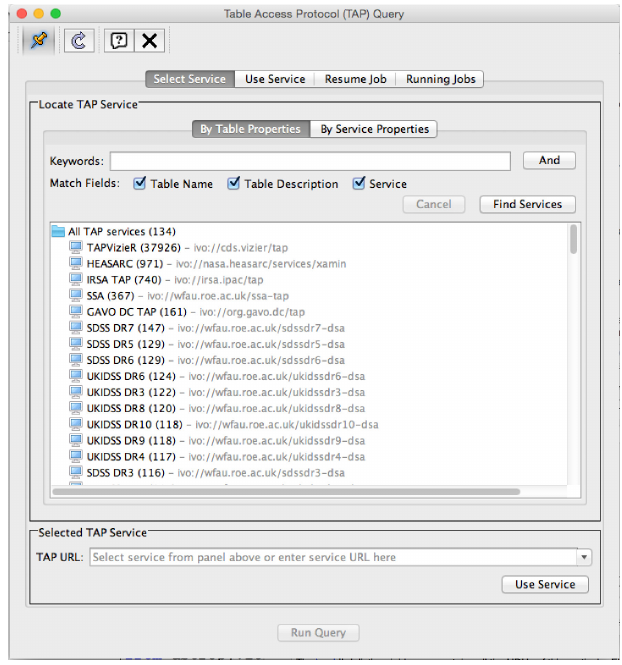
Fig. 55.— The Table Access Protocol (TAP) window from the list in the window, or by using the field near the bottom to enter the URL of a specific astronom- ical data base service. We will choose the ESA data base for the astrometry satellite Gaia, which is simply listed as GAIA in the TAP window. Double-click on GAIA and you will get additional information, as shown in Fig. 56. In the field on the left, you can see the specific